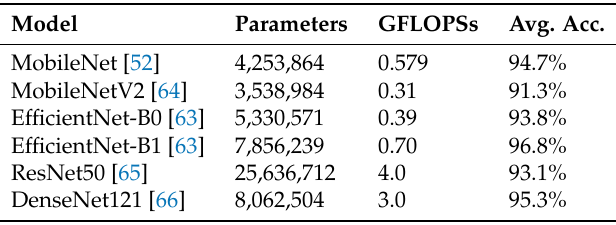
Table 2. Comparison between different CNN architectures using 18% of the available dataset and transfer learning to train the networks. MobileNet, for this specific application, is a good trade-off between performance and computational cost.